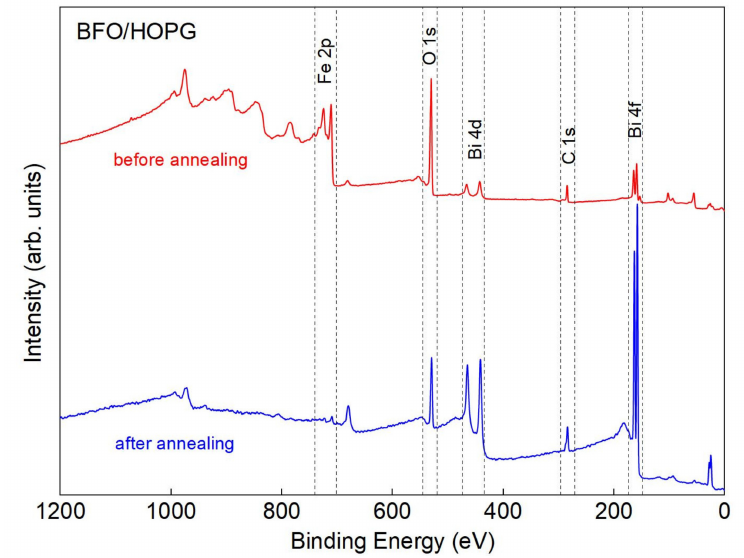
Figure 4. XPS of the BFO / HOPG sample, below—before annealing, above—after annealing at a temperature of 923 K. The main peaks characterizing the compounds formed during the synthesis are